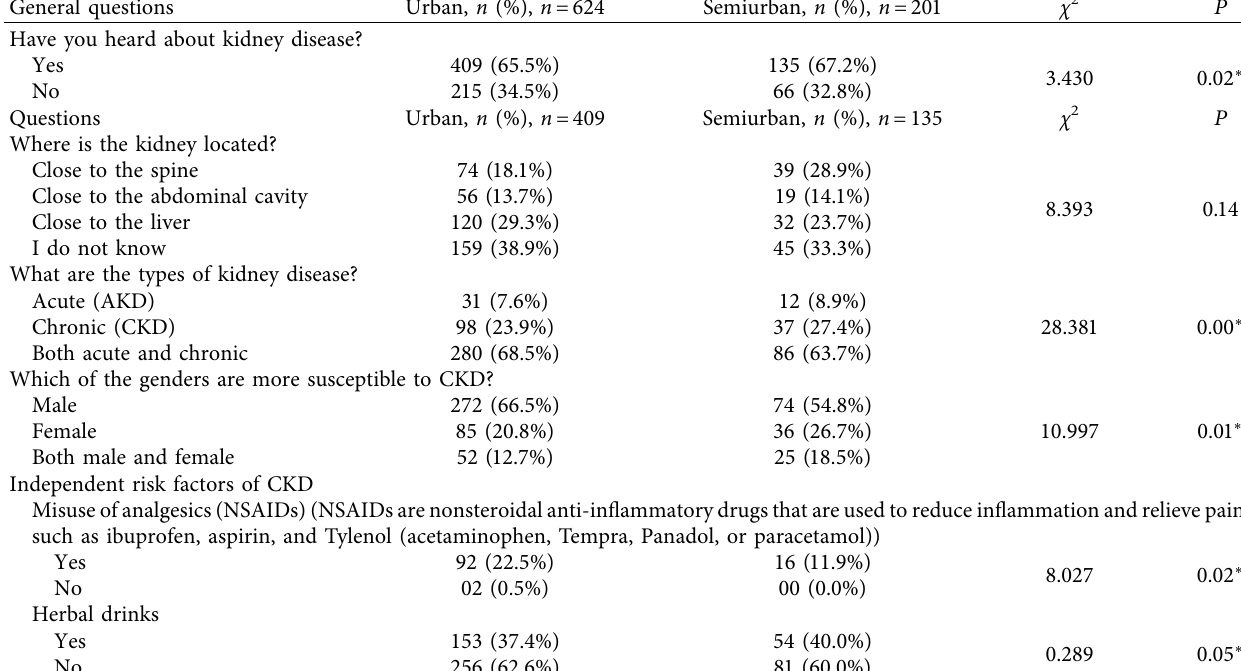
Table 2: Bivariate analysis of respondents’ knowledge of KD and chronic kidney disease risk factors by location ( N � 825). General